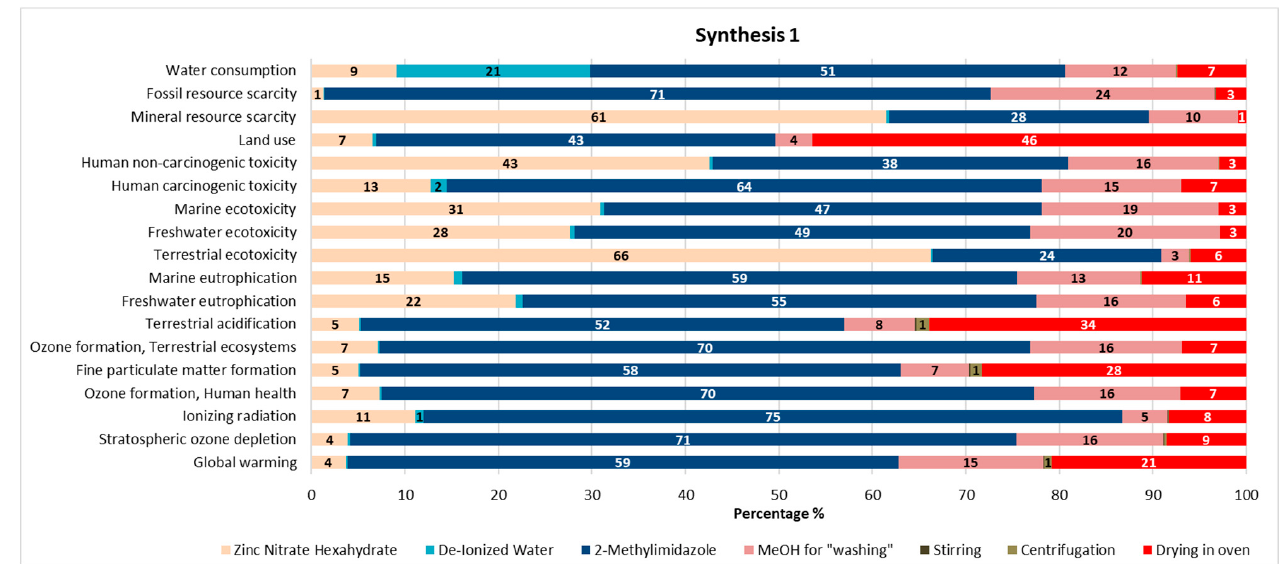
Energies 2021 , 14 , x FOR PEER REVIEW 11 of 23 Figure 4. Life Cycle Assessment of the 1st synthetic approach of ZIF-8. Method: ReCiPe 2016, midpoint (H) V.1.01.